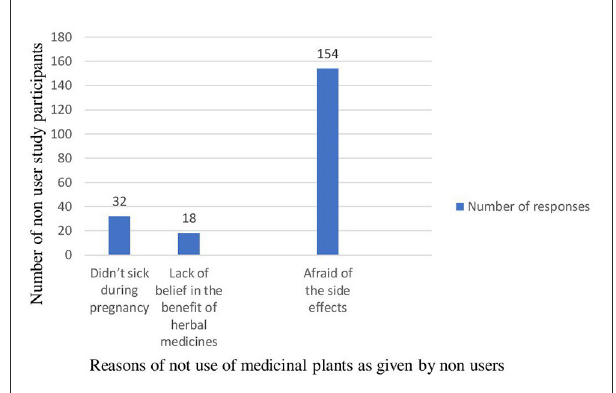
FIGURE1 Reasons for not using medicinal plants among non-users in East Gojjam Zone, Northwest Ethiopia, 2021 ( N = 204).